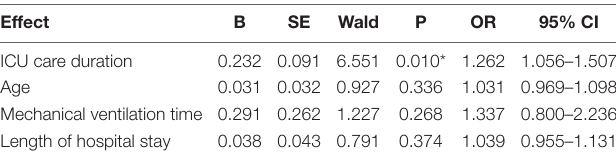
TABLE 4 | Multivariate logistic analysis of risk factors associated with post-operative delirium. Effect